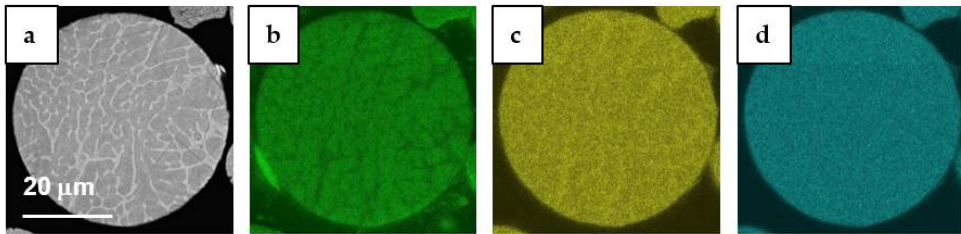
Figure 7. Element distribution in Ni 36 Al 27 Co 37 powder particle after spheroidization: ( a ) BSE-image of the area investigated, ( b ) Al, ( c ) Co and ( d ) Ni.